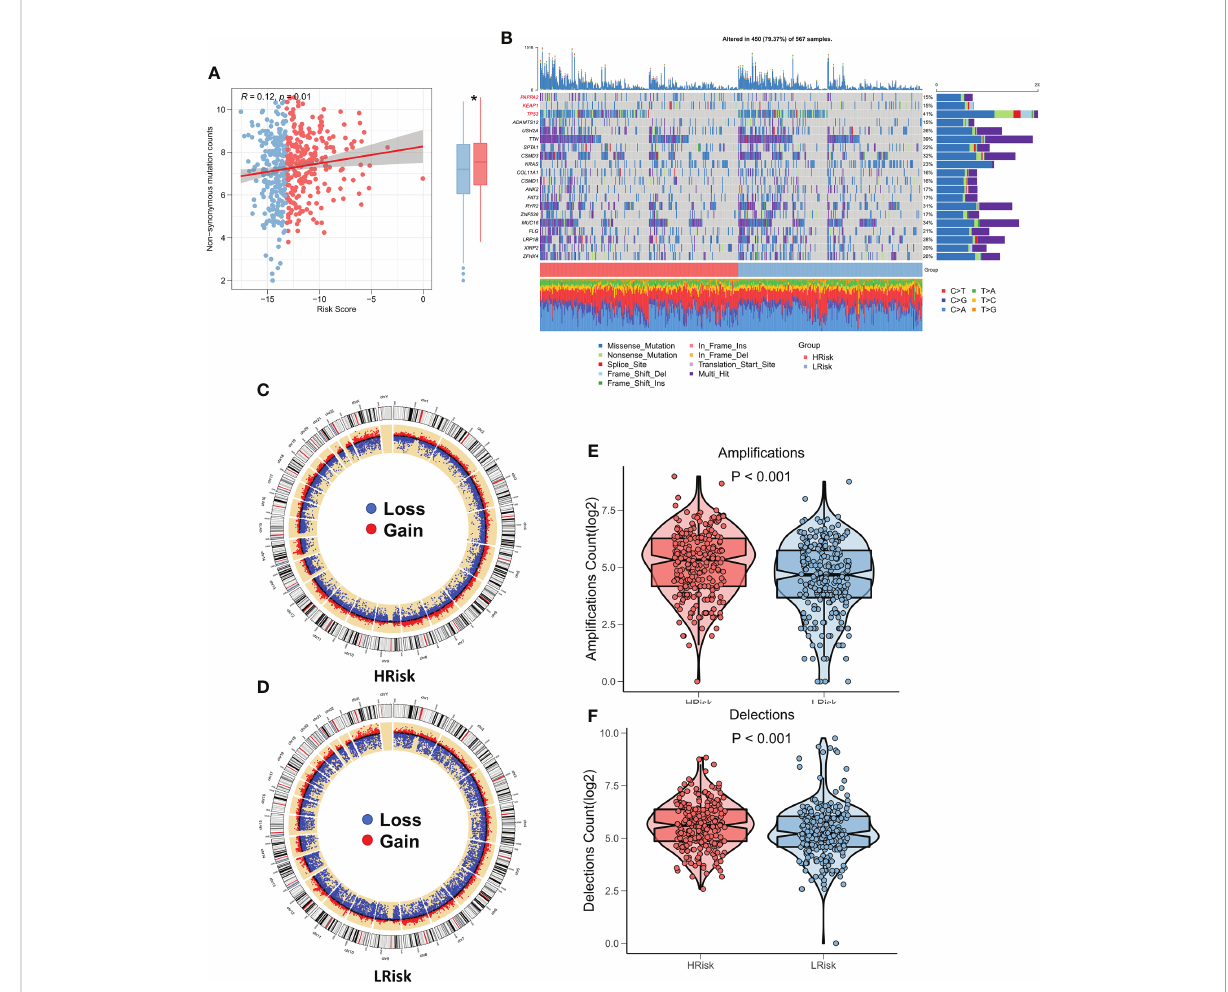
FIGURE 7 Genomic variation landscape of CRGs-related deep learning models. (A) Box plot showing the difference in TMB among the two risk groups. (B) Oncoplot of signi fi cantly mutated genes between the two risk groups. (C) The loop diagram shows the CNV landscape in the high-risk group. (D) The loop diagram shows the CNV landscape in the low-risk group. (E) Box plots represent the variation in chromosome ampli fi cation numbers in the high-risk and low-risk groups. (F) Box plots display the variation in the number of chromosome deletions among the two risk groups. *P <